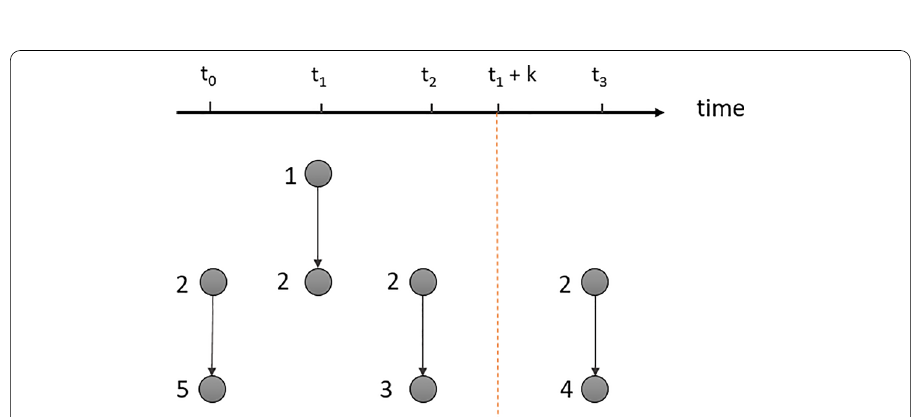
Fig. 3 An example of temporal paths. In this example there is a temporal path between node 1 and 3, if we consider an infectious period k, there is no path between 1 and 4. There is no temporal path between 1 and 5, since the movement from 2 to 5 occurs prior to the movement from 1 to 2; if t 3 2 would be connected to 3, 4 and 5 in the static